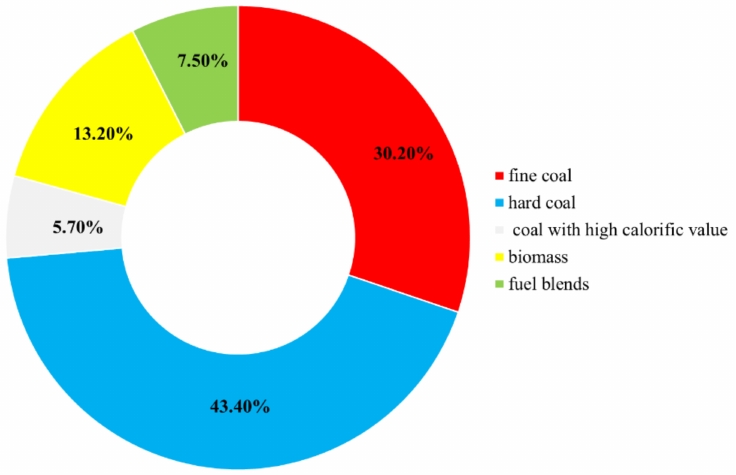
Figure 4. Distributions of answers to the question: “What type of fuel is used in your enterprise?”.